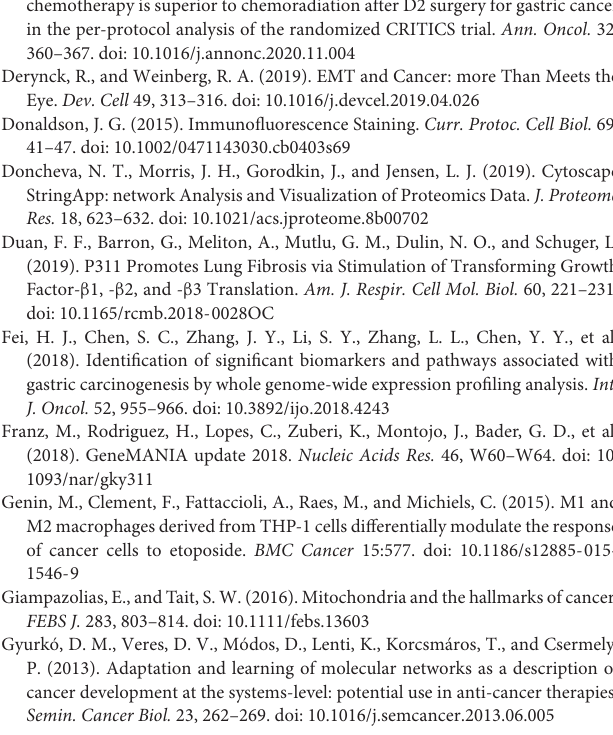
Supplementary Figure 1 | Prognostic roles of 10 hub genes and relationship with sample types in patients from the TCGA-STAD dataset. (A–J) Expression of FBLN1 , ELN , FN1 , COL1A2 , LUM , COL1A1 , COL3A1 , VCAN , BGN , and ACTA2 in different sample types (normal vs. tumor) based on the TCGA-STAD dataset. High expression, red; low expression, blue. TPM: Transcripts Per Kilobase Million. (K–T) Survival analysis based on FBLN1 , ELN , FN1 , COL1A2 , LUM , COL1A1 , COL3A1 , VCAN , BGN , and ACTA2 expression. Supplementary Figure 2 | Validation of cell transfection